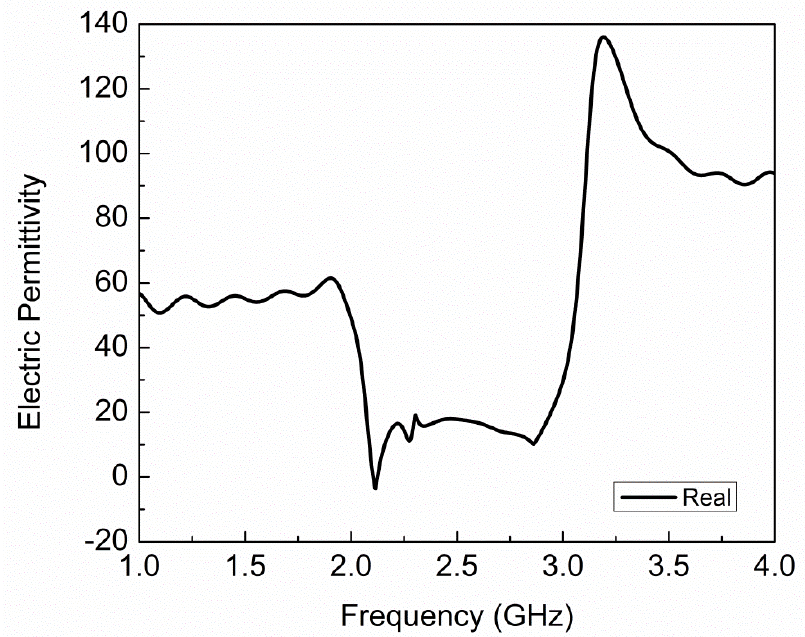
Figure 4. Extracted plot of electric permittivity for proposed sensor, showing negative permittivity from 2.10 GHz to 2.12 GHz, and maximum value of negative permittivity is −3.57 at 2.11 GHz.